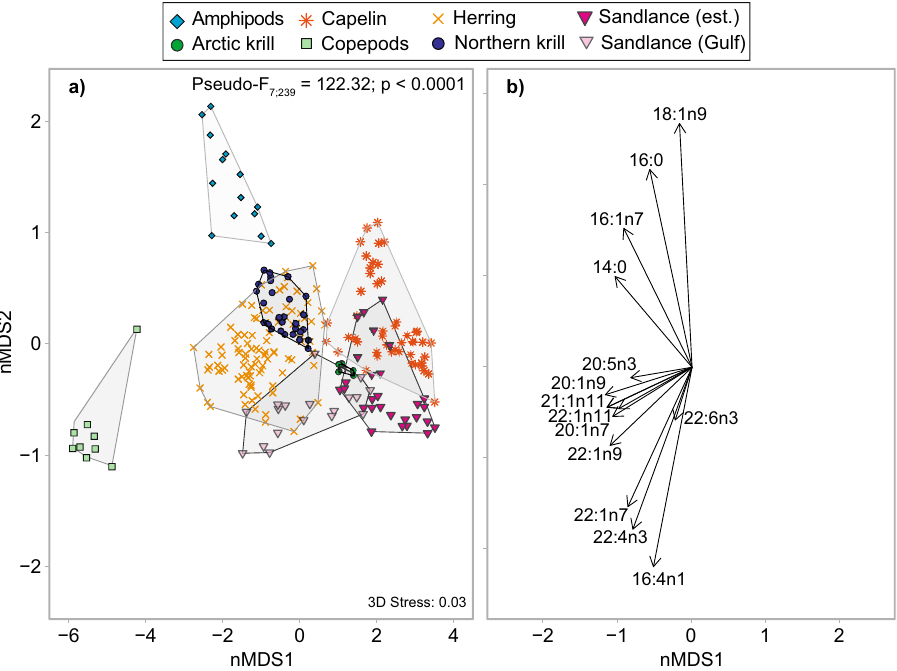
Figure 1. Multidimensional scaling (n-MDS) ordination in Euclidean space of (a) the fatty acid signature of potential prey sampled in the Estuary and Gulf of St. Lawrence between 1999 and 2005, and (b) fatty acids responsible for these groupings (Pearson correlations). Calculations were based on the extended dietary fatty acid subset (n = 39). Detailed interactive and static 3D n-MDS is also available in the Supplementary Fig. S1 online and in Mendeley data repository (https:// doi. org/ 10. 17632/ 6nxhj x9gbw.1).